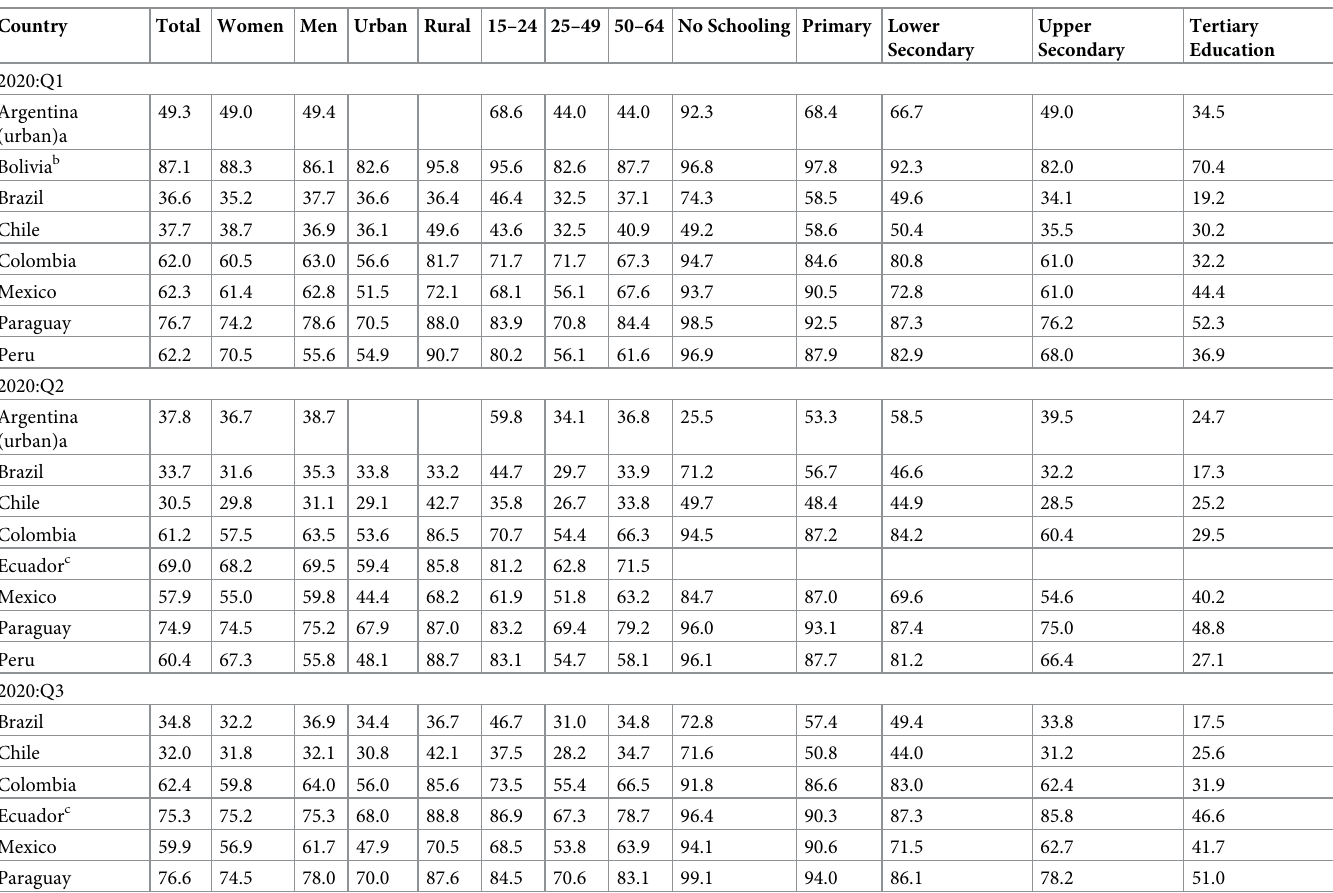
Table 3. Demographic profile of the population employed in the informal sector as a percentage of employment, selected Latin American countries, 2020 (percent).